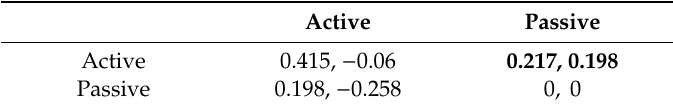
Table 6. Payo ff matrix A for 2 × 2 (Scrum Master vs. OTM) game for the least e ff ective team with